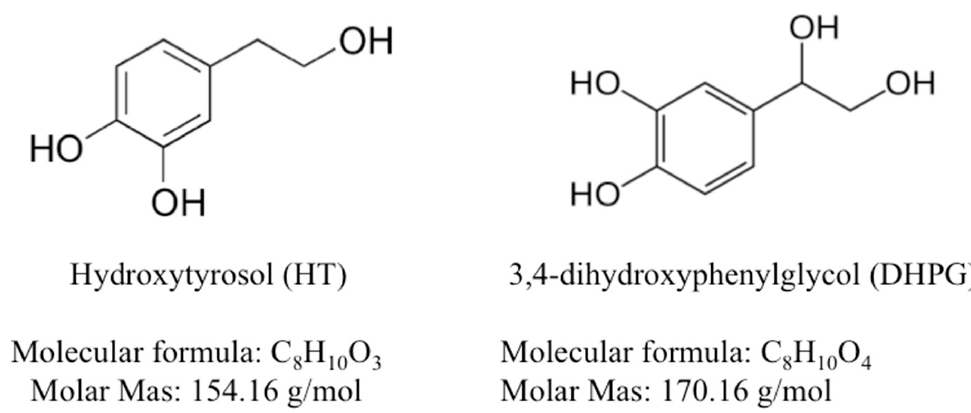
Figure 1. Chemical structure of olive oil-derived antioxidants used in the present study.